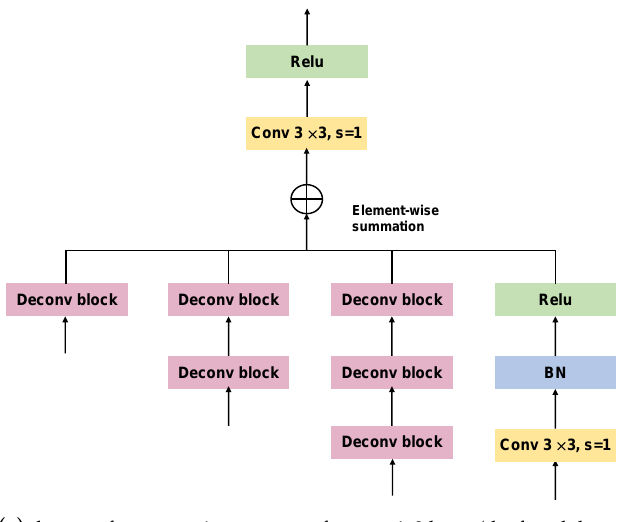
Figure 3. The architecture of our proposed Dense-TCB. ( a ) The transfer connection structure for conv7 layer (the second layer), ( b ) The transfer connection structure for conv5_3 layer (the third layer), ( c ) the transfer connection structure for conv4_3 layer (the fourth